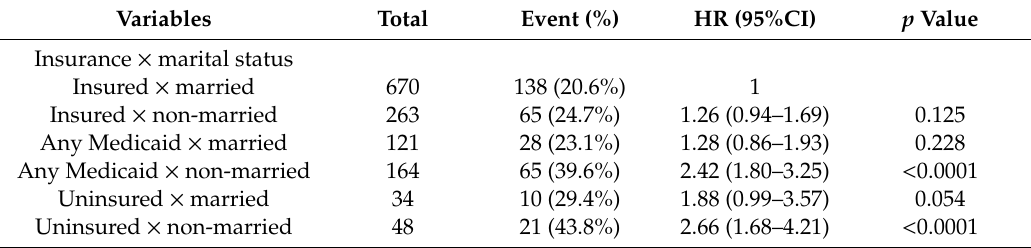
Table 2. Univariate analysis for 5-year overall survival.